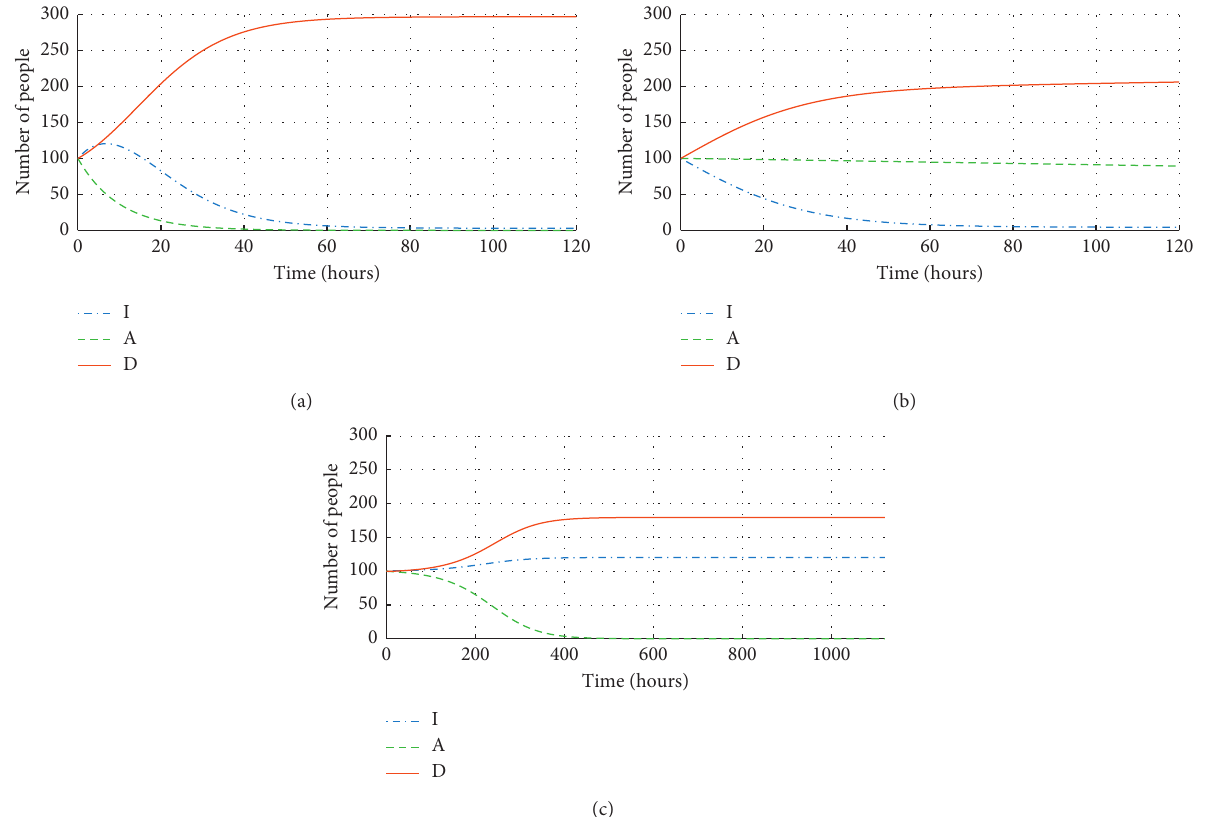
Figure 5: Examples of the steady state E I ( 0 ) � 100 , A ( 0 ) � 100, and D ( 0 ) � 100 and parameters’ values 2 simulated with initial conditions from Table 3. (a) Example 7. (b) Example 8. (c) Example